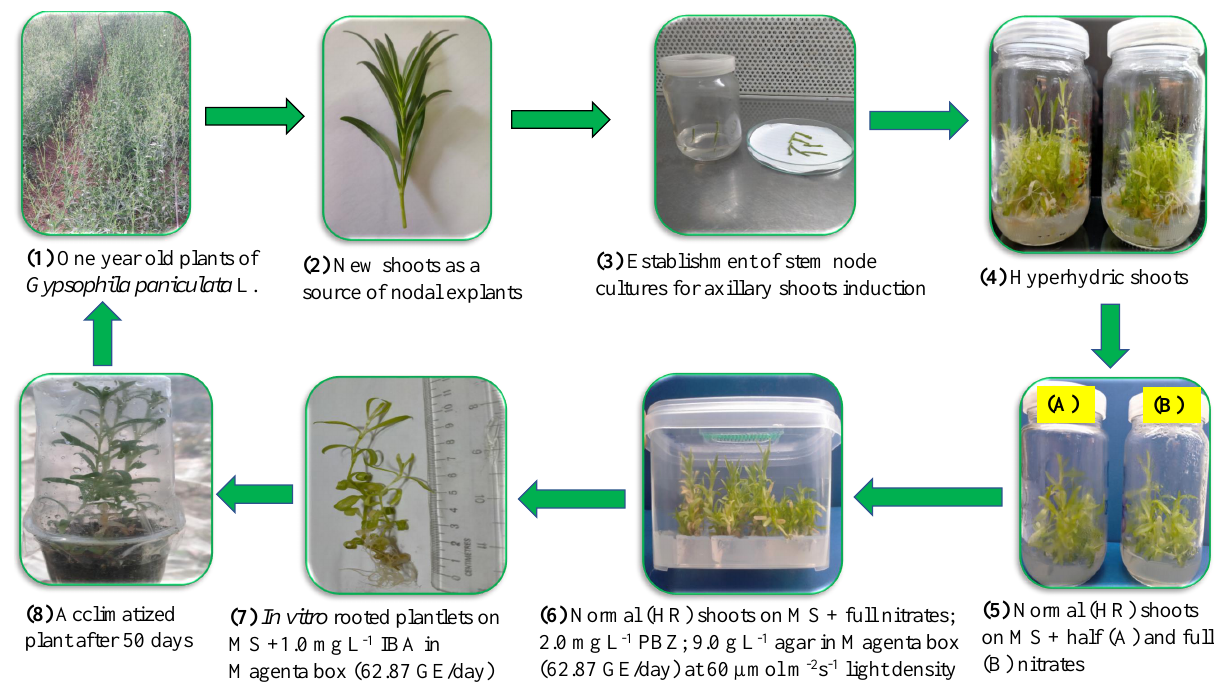
Figure 2. A novel protocol for producing healthy, non-hyperhydric in vitro plantlets of G. paniculata by recovering from hyperhydrated in vitro shoots, where HR is hyperhydricity